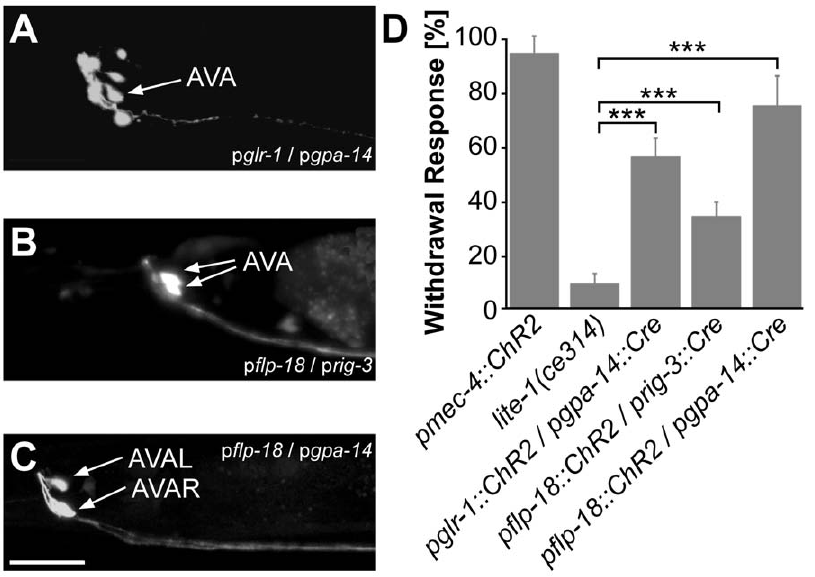
Figure 5. Expression pattern and behavioral responses of animals generated towards ChR2 expression in AVA by using Cre recombinase. GFP fluorescence (confocal stacks) in animals expressing ChR2::mCherry and GFP (bicistronically co-expressed) using the promoter combinations glr-1 and g pa-14 A ), flp-18 and rig-3 B ), or flp-18 and gpa-14 C ). Scale bar=20 m m. D ) Behavioral assay testing withdrawal reactions in response to 470 nm blue light illumination were as described in Fig. 3D (n=14).